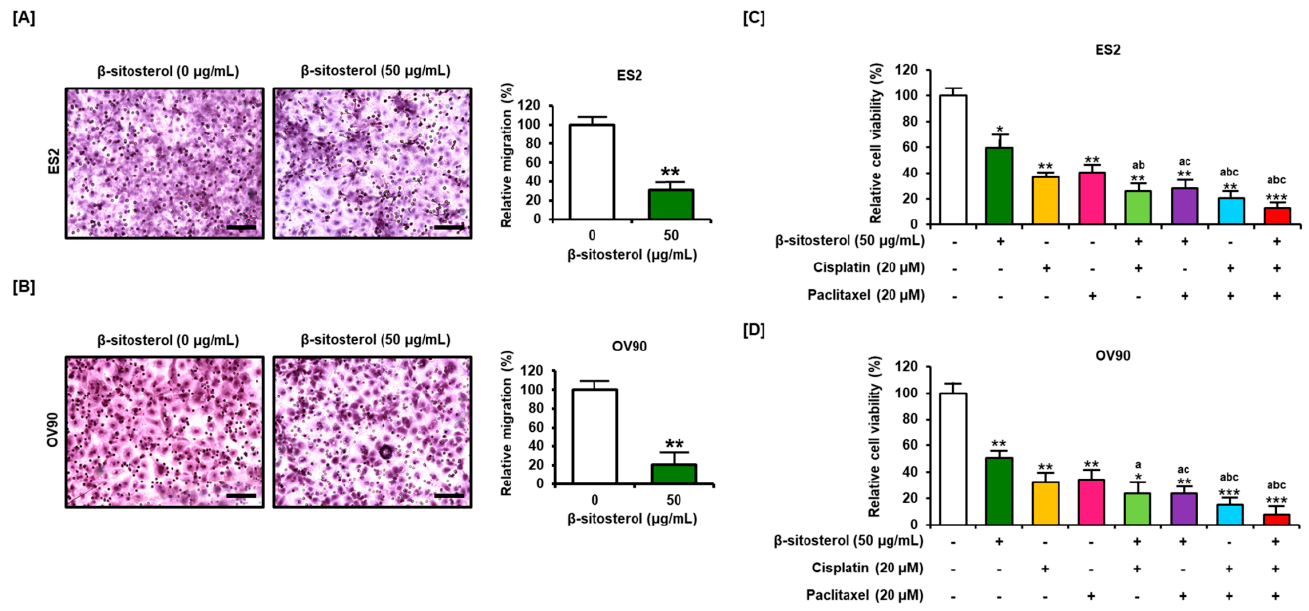
Figure 7. Anti-migration and -proliferation effects of β -sitosterol with or without anticancer drugs. ( A , B ) Migration of ovarian cancer cells following treatment with β -sitosterol in ES2 ( A ) and OV90 ( B ) cells. ( C , D ) Enhancement of the anti-proliferation effect of existing conventional chemotherapeutic agents by β -sitosterol. Bar graphs show the viability (percentage) of ovarian cancer cells following treatment with combinations of β -sitosterol and cisplatin or paclitaxel. Data are shown relative to the vehicle-treated controls (100%). The asterisks indicate significant differences between treated and control cells (*** p < 0.001, ** p < 0.01, and * p < 0.05). Lower-case letters indicate significant differences within the group as follows: ‘a’ compared to β -sitosterol, ‘b’ compared to cisplatin, and ‘c’ compared to paclitaxel.